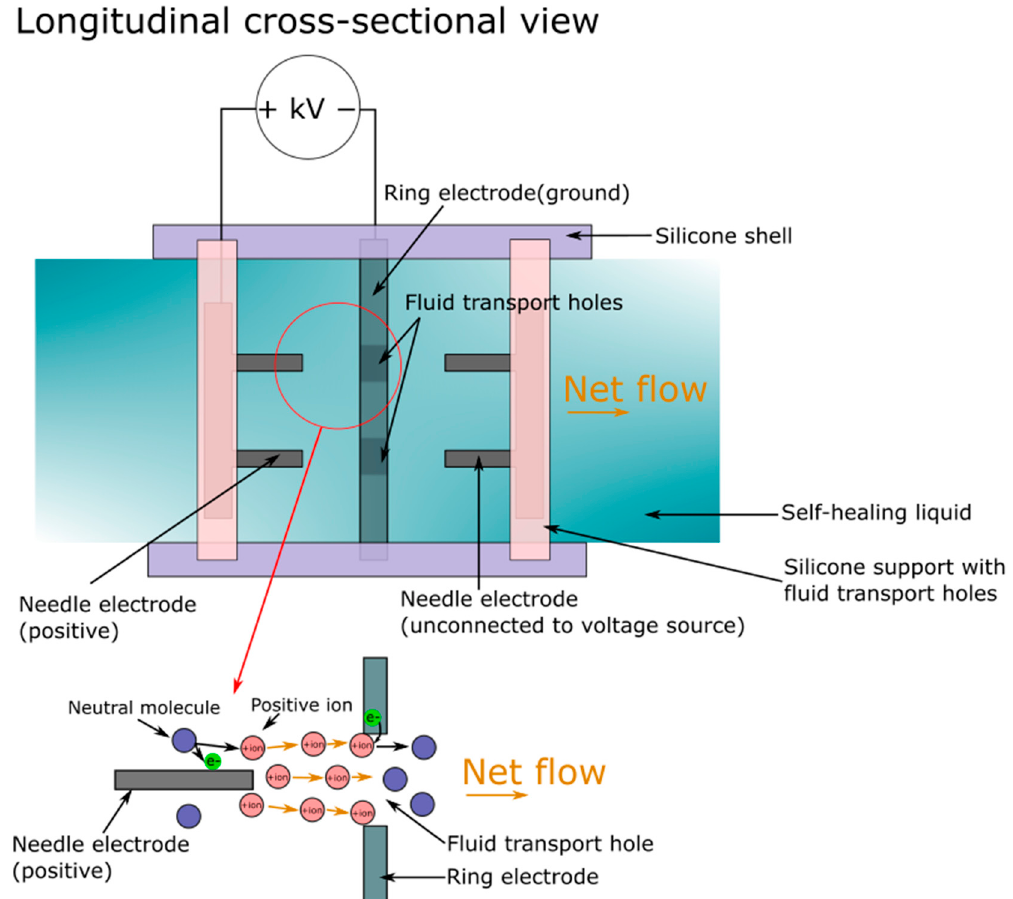
Figure 12. The structure of a cylindrical self-healing soft pump. Illustration inspired by Tang et al. [112]. There are two electrode pairs (pair1: left needle electrode + ring electrode, pair2: right needle electrode + ring electrode), and only one pair is powered at a time. Flow direction can be switched by disconnecting the left needle electrode and connecting the right needle electrode to the voltage source.